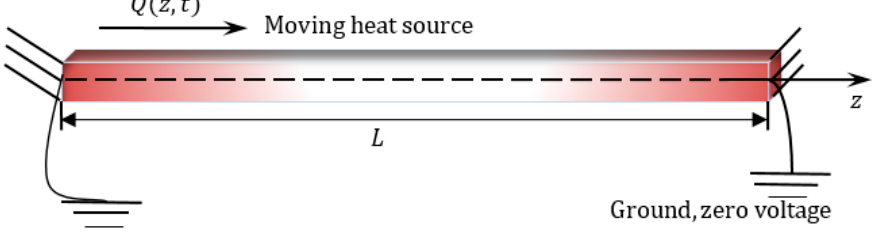
Figure 1. A pictorial representation of a piezoelectrically limited flexible rod.